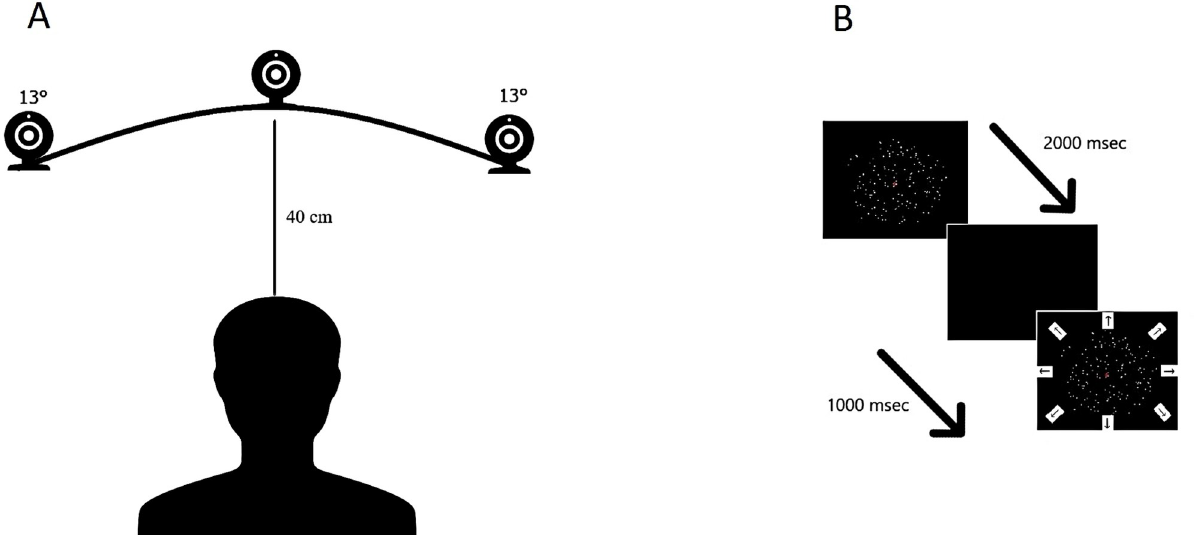
Fig 1. Experimental setting for the Critical Flicker Fusion test (A) and Motion coherence test (B). For the Critical Flicker Fusion test, the subject was placed at 40 cm eye-target distance (subtending 5.7˚ visual angle) from the flicker tool with the chin placed on a chinrest. The flicker tool was positioned at three different angles in the visual field as illustrated (centrally, at 13˚ visual angle to the right, and at a 13˚ visual angle to the left). For the Motion coherence test, the subject was placed at 60 cm eye-target distance (subtending 6.2˚ visual angle) from the stimulus.